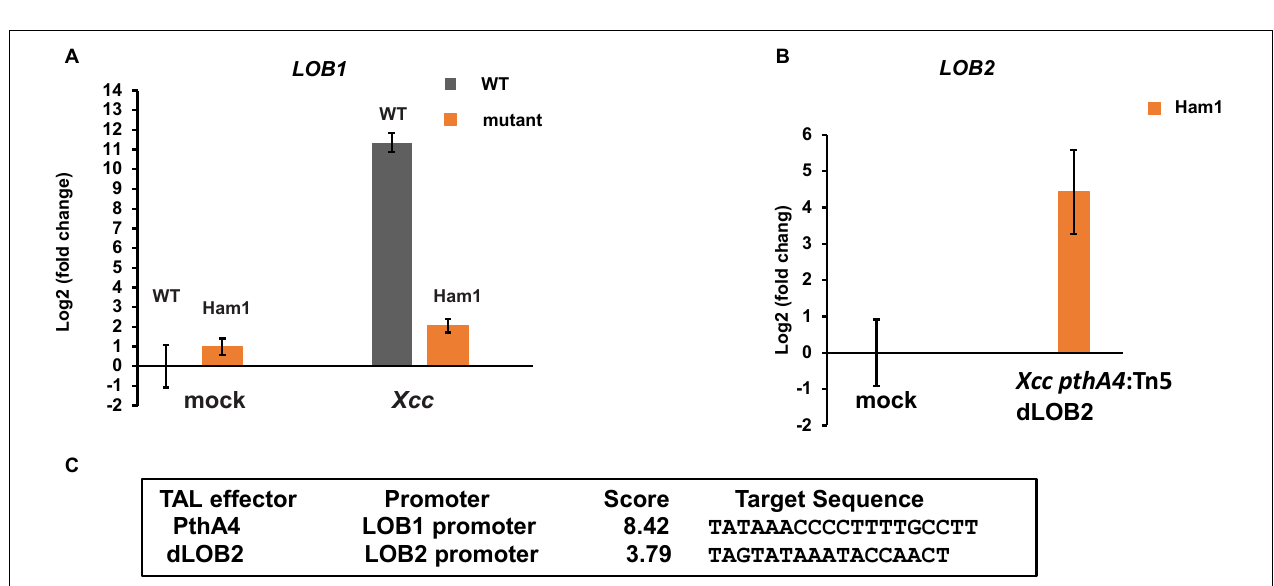
FIGURE 6 | Induction of CsLOB1 by Xcc is abolished in a biallelic mutant line of Hamlin sweet orange. (A) RT-qPCR analyses of CsLOB1 relative expression in leaf samples collected at 48 h post inoculation with indicated treatments. Mock, mock inoculation with buffer; Xcc , inoculation with wild-type Xcc (10 8 CFU/ml); dLOB2, inoculation with Xcc pthA4 :Tn5 carrying designer TAL effector dLOB2 (10 8 CFU/ml). Each treatment has three biological repeats. Ham1, a representative biallelic mutant line #1 (aka Ham1). All expression levels were normalized to the WT mock. The GAPDH gene was used as an endogenous control. (B) RT-qPCR analysis of LOB2 relative expression of leaf samples collected at 48 h post inoculation with indicated treatment. All expression levels were normalized to the Ham1 mock. The GAPDH gene was used as an endogenous control. (C) Finding promoter binding site for TAL effectors by using Target Finder (https://tale-nt.cac.cornell.edu/node/add/talef-off). Designer TAL effector dLOB2 shows affinity to the LOB2 promoter, but not the LOB1 promoter.